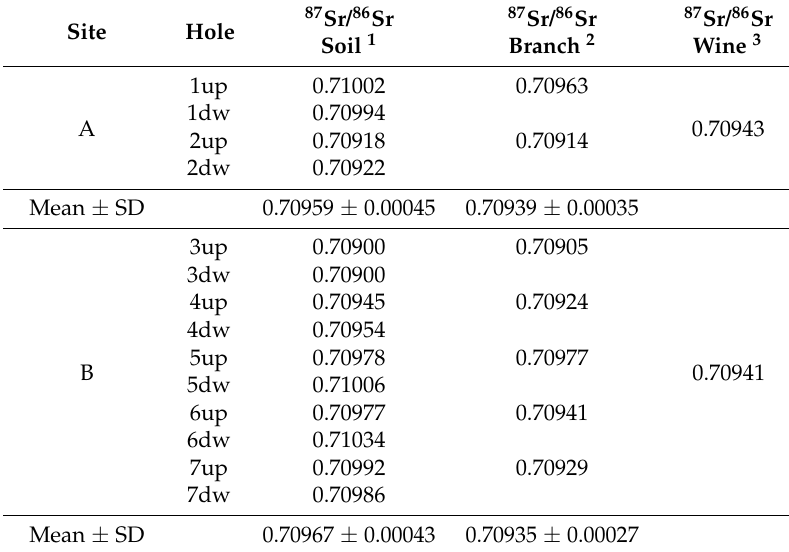
Table 3. Values of the 87 Sr/ 86 Sr ratio measured for soils, vine branches, and wines sampled from a producer in the Chianti Classico wine